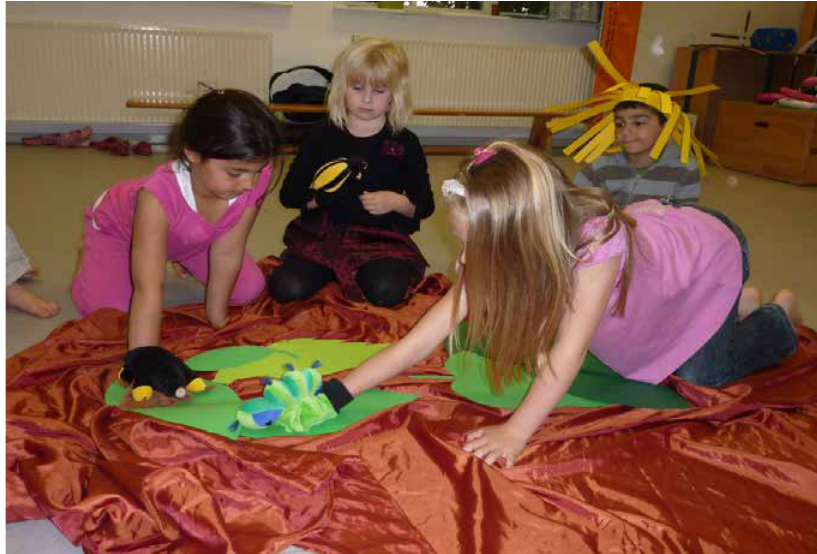
Figure 4: Children taking part in the group exercise: one girl is counting the leaves and moving each counted leaf towards herself. (Photo of the practical